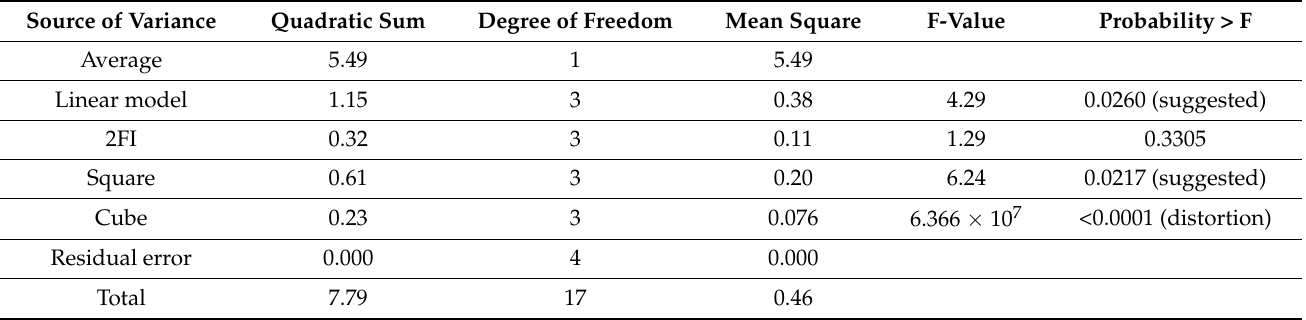
Table 12. Variance analysis and comparison of multiple models.